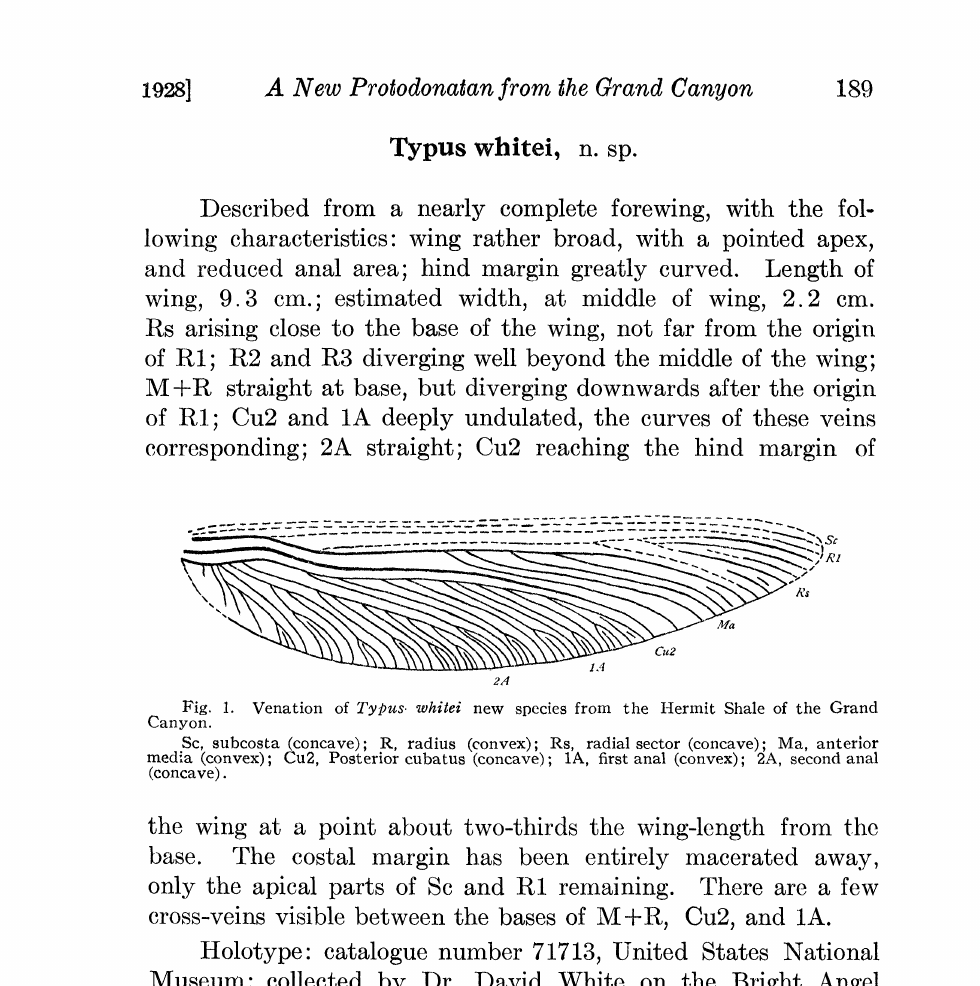
Fig. 1. Venation of Typus. whitei new species from the Hermit Shale of the Grand Canyon. Sc, subcosta (concave); R, radius (convex); Rs, radial sector (concave); Ma, anterior media (convex); Cu2, Posterior cubatus (concave); 1A, first anal (convex); 2A, second anal (concave).